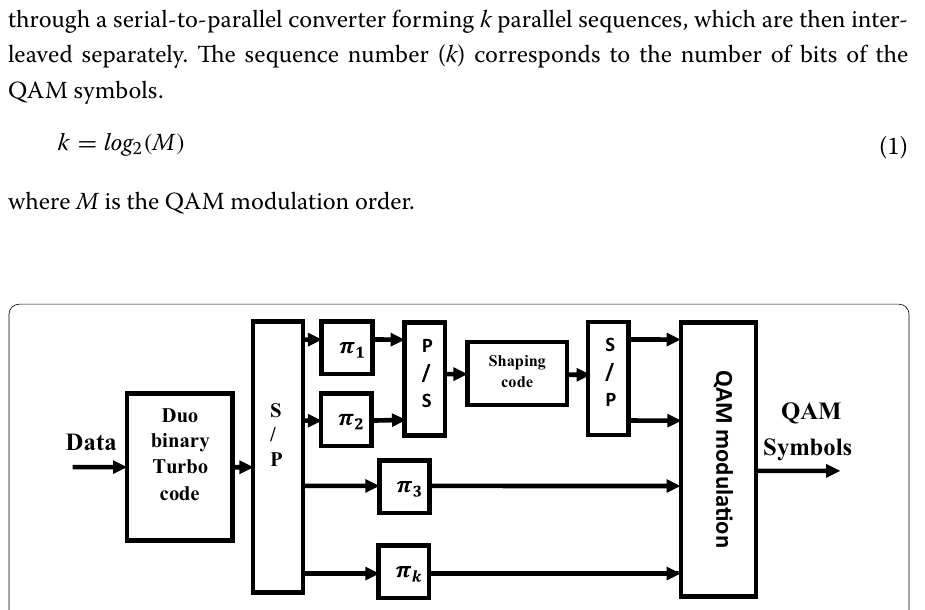
Fig. 1 Transmitter block of the BICM constellation shaping scheme. The transmission part of the proposed SISO BICM constellation shaping scheme (the i th BICM_CS block in the transmission part of the global adaptive